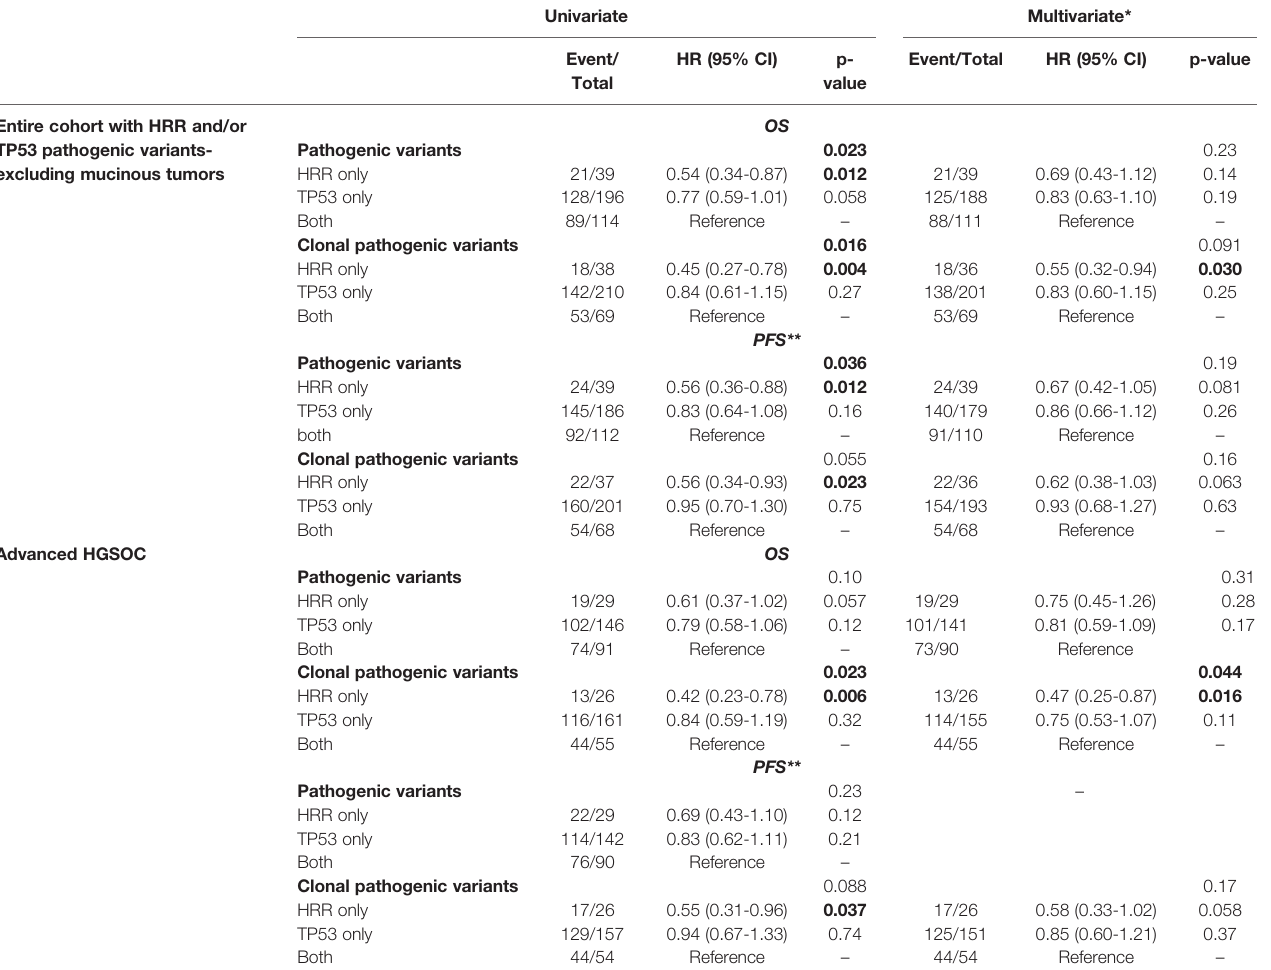
TABLE 2 | Cox regression analysis with respect to OS and PFS in patients with HRR and/or TP53 pathogenic variants.